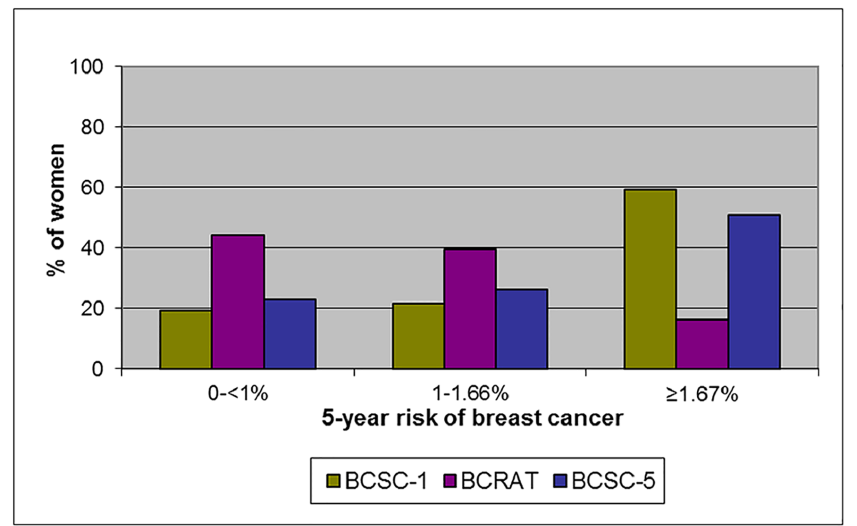
Fig 1. Categories of predicted risk of developing breast